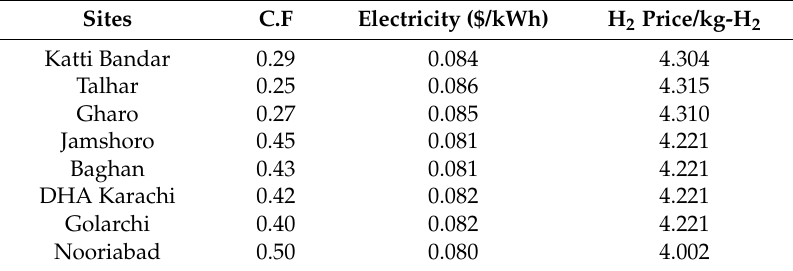
Table 7. Cost of electricity and Renewable